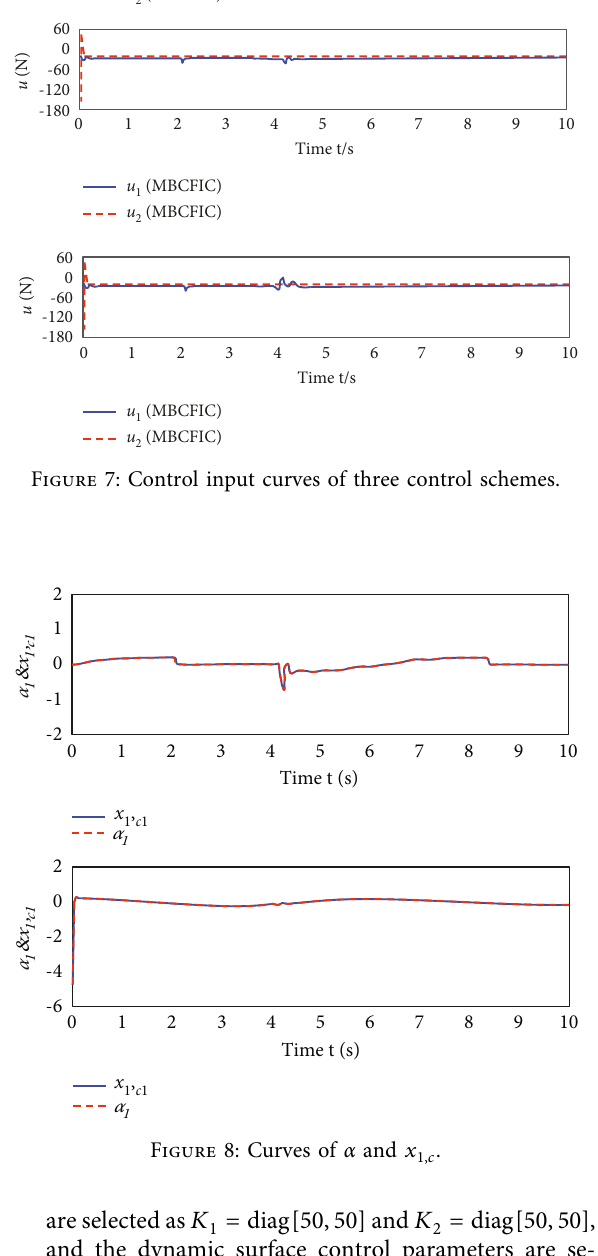
Figure 8: Curves of α and x